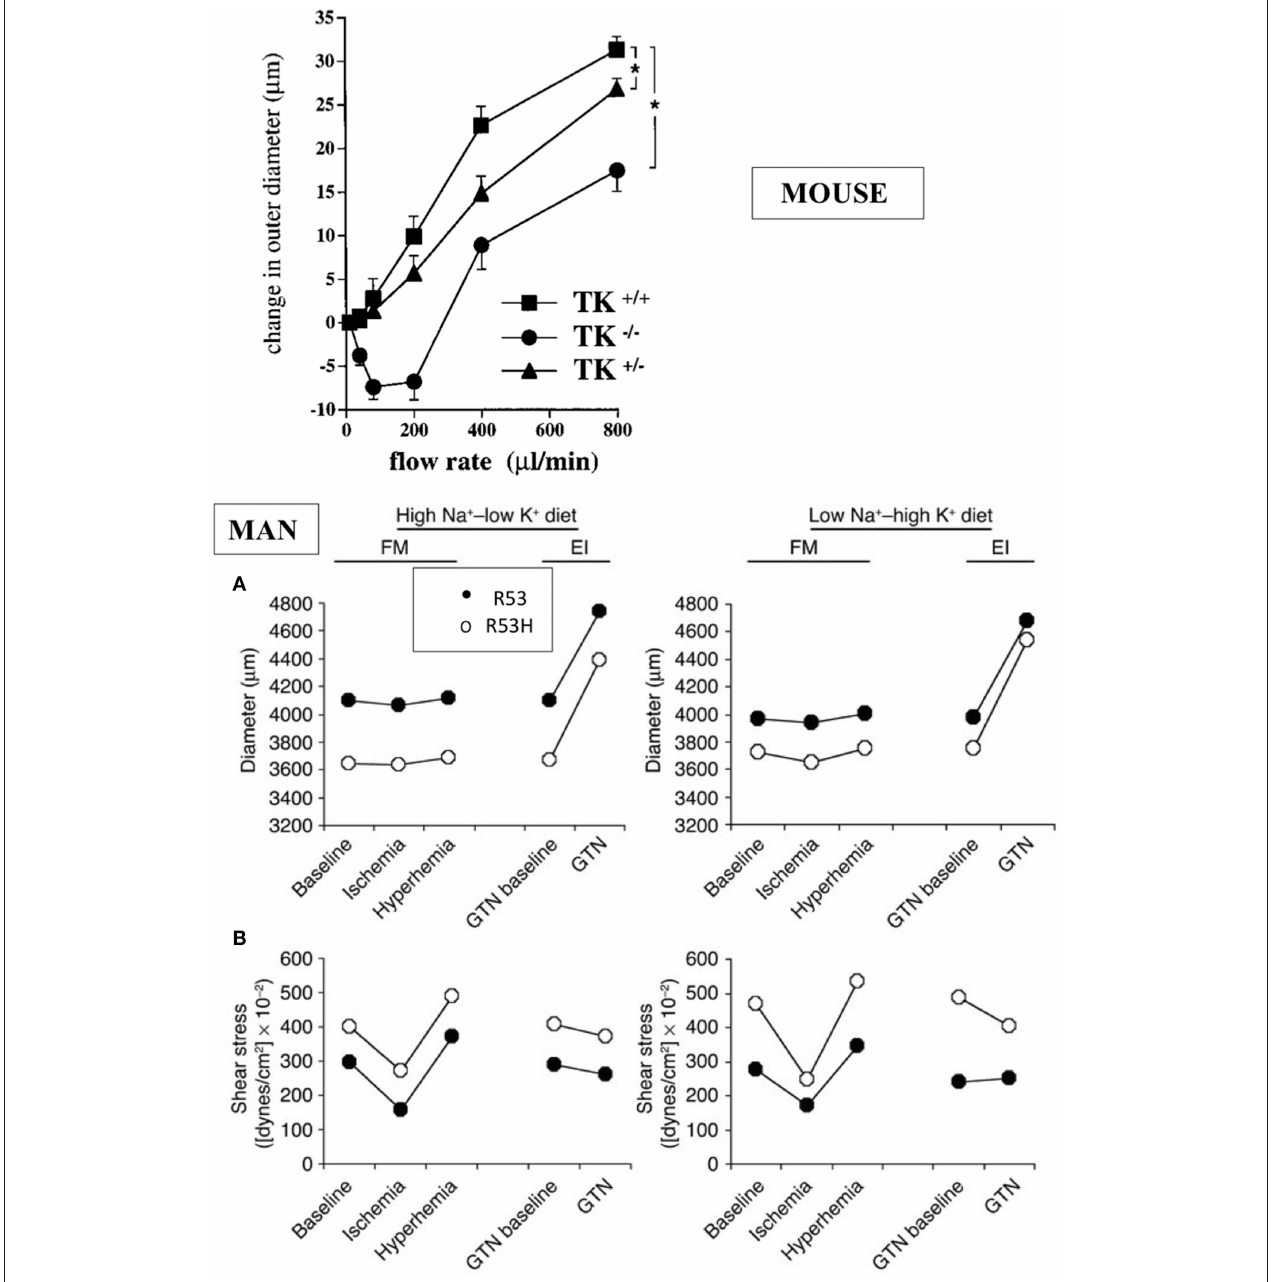
FIGURE 2 | Arterial dysfunction in K1 deficient mice and human subjects partially deficient in K1 activity. Upper graph: impairment of flow-induced vasodilatation in carotid artery of K1 deficient mice. Homozygote (TK − / − ) and heterozygote (TK + / − ) mice with inactivated K1 gene compared to littermate wild type animals (TK + / + ). * p < 0.05 compared to littermate TK + / + . Note paradoxical vasoconstrictor response at low flow rate in TK − / − and partial defective phenotype of TK + / − mice (see text for discussion). Reproduced from Bergaya et al. (15). Lower panels: arterial dysfunction in subjects carrying the defective R53H mutation of K1 (heterozygote) and having roughly 50% K1 activity level of non-mutated, homozygous R53 subjects. Subjects were studied by vascular echotracking of brachial artery in basal condition, during hand ischemia and reactive hyperhemia and after nitroglycerin (GTN) administration. Study was repeated at contrasted dietary Na/K intake. Low Na-High K stimulates K1 synthesis in the kidney. Note increase in sheer stress (A) in R53H subjects with paradoxical reduction of arterial diameter (B) . Reproduced from Azizi et al. (16). Observations in both man and mouse are indicative of endothelial dysfunction (see text). The R53H subjects also display minor epithelial abnormalities Mouse and human genetic studies thus allowed recognizing, related to calcium or potassium handling, similar to the consistently in both species, the physiological role of K1 in the mouse (27, 28). circulation and its role in the